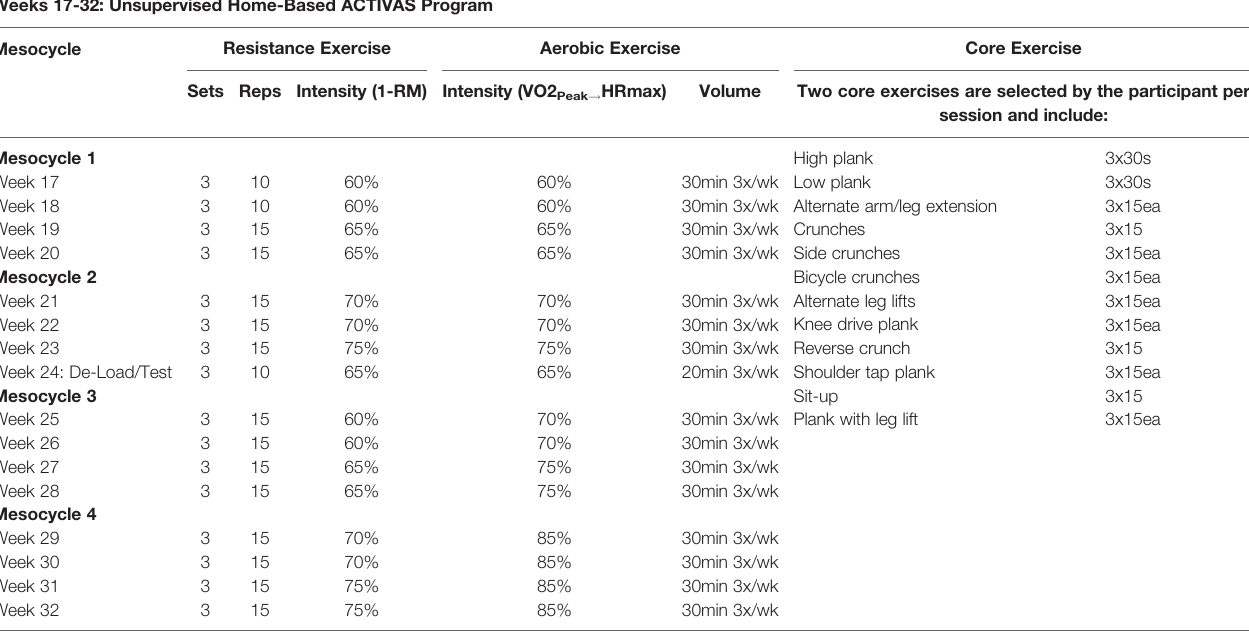
TABLE 2 | Overview of Phase 2: Unsupervised home-based intervention (ACTIVAS program). Weeks 17-32: Unsupervised Home-Based ACTIVAS Program Resistance Exercise Aerobic Exercise Core ExerciseMesocycle Volume Two core exercises are selected by the participant per session and include: Mesocycle 1